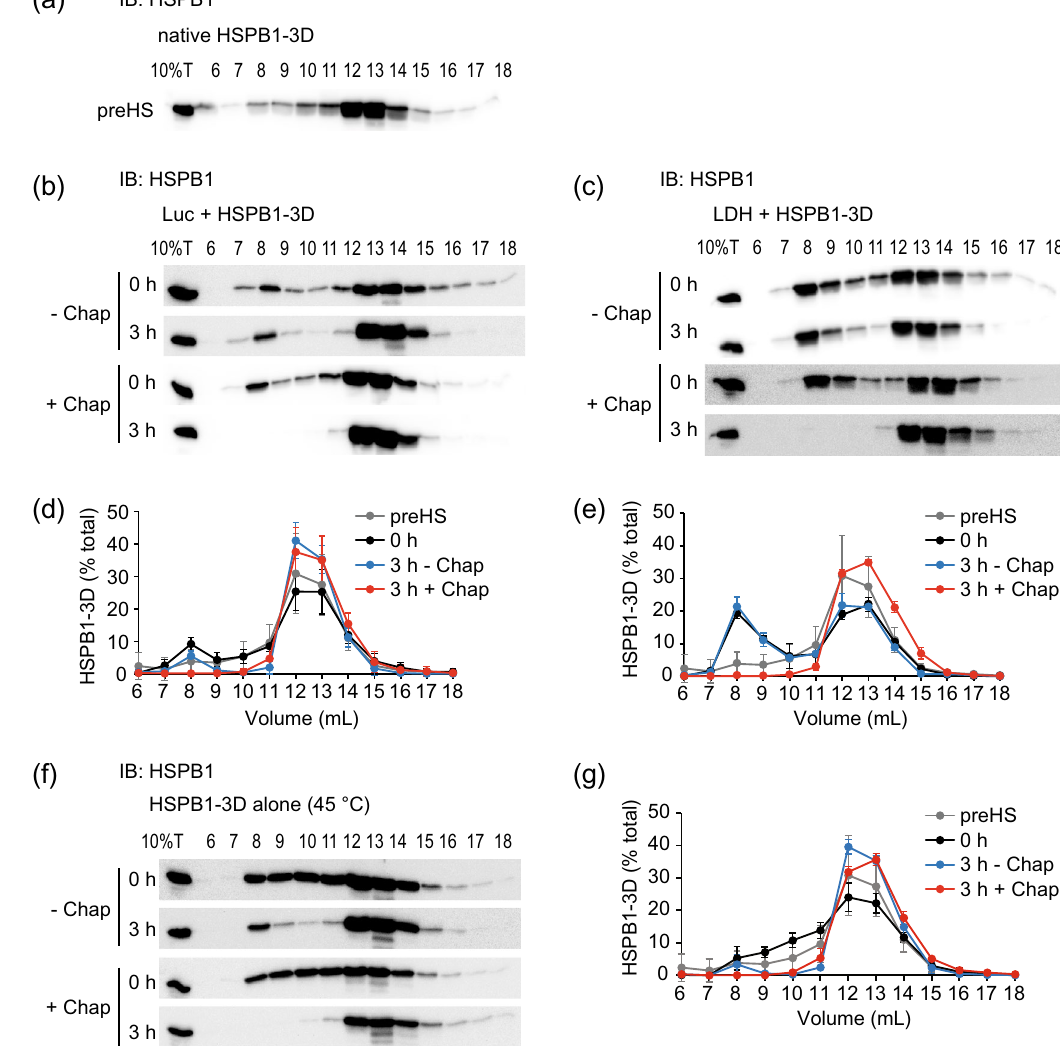
Figure 4. HSPB1-3D changes oligomeric state during disaggregation. ( a – c ) The elution patterns of HSPB1-3D ( a ) before the heat shock or in the disaggregation reactions with ( b ) luciferase or ( c ) LDH as in Fig. 3c–f, were assessed by SEC and immunoblot (IB). ( d , e ) Quantification of HSPB1-3D in the reactions with ( d ) luciferase and ( e ) LDH from B and C are shown as percentage of the total amount of immunoblot signal. ( f ) HSPB1-3D in the absence of substrates was submitted to heat shock at 45 ℃ , transferred to reaction buffer with (+ Chap) or without (− Chap) chaperones and analyzed by SEC and immunoblot. ( g ) Quantification of HSPB1-3D elution pattern in f. Error bars show standard deviations, n ≥